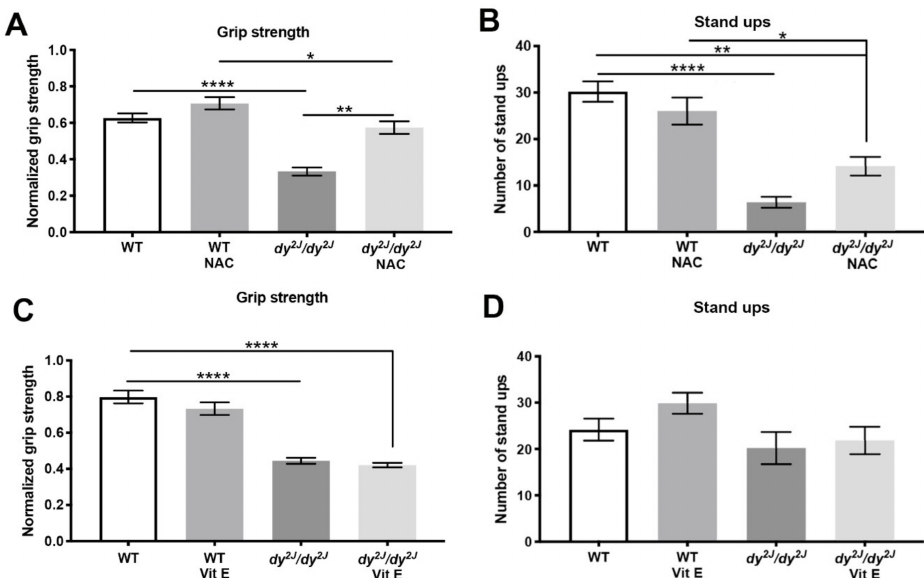
Figure 2. ( A,C ): Normalized forelimb grip strength. Calculations were done by dividing force (KgF) by final body weight in grams. Results are expressed as normalized grip strength in 8 WT, 10 WT N-acetyl-L-cysteine (NAC), 5 dy 2J / dy 2J , 6 dy 2J / dy 2J NAC and 11 WT, 8 WT vit E, 5 dy 2J / dy 2J and 6 dy 2J / dy 2J vit E; ( B ) Number of stand ups in 10 WT, 11 WT NAC, 5 dy 2J / dy 2J , 6 dy 2J / dy 2J NAC and ( D ) 11 WT, 7 WT vit E, 5 dy 2J / dy 2J , 6 dy 2J / dy 2J vit E. * p < 0.05, ** p < 0.01, *** p < 0.001 and **** p <